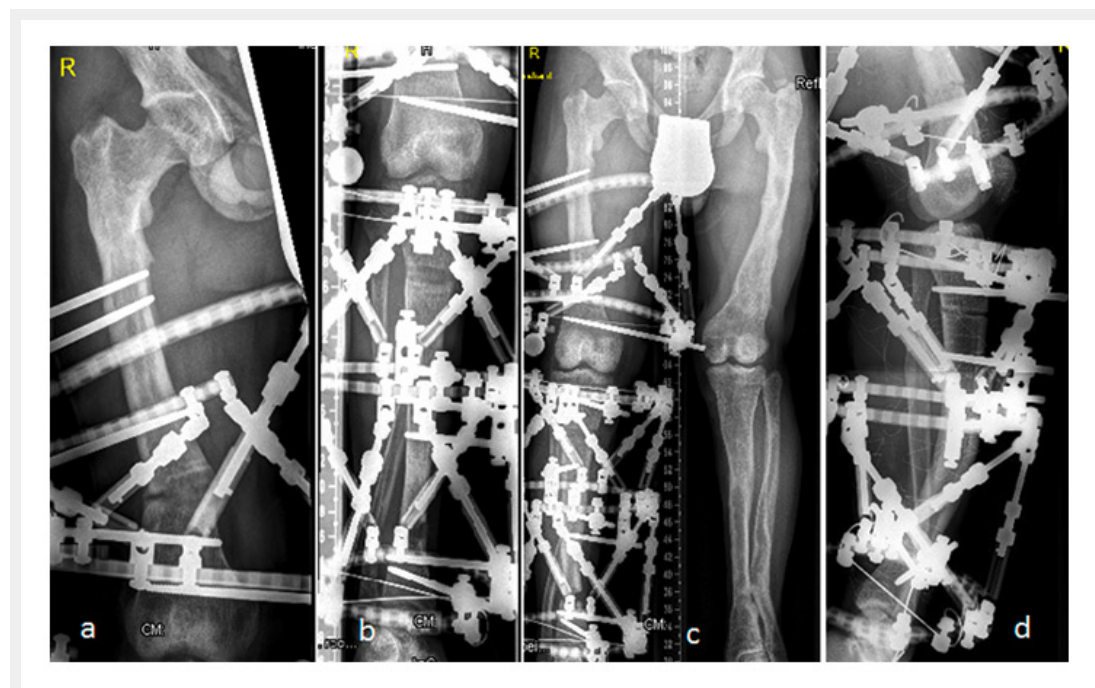
Figure 3 (a,b,c). Femoral or proximal tibial osteotomies (in different patients). It is evident that the severe varus deformity was corrected by gradual distraction using a Taylor spatial frame. External fixation allowed fine-tuning of the alignment postoperatively.